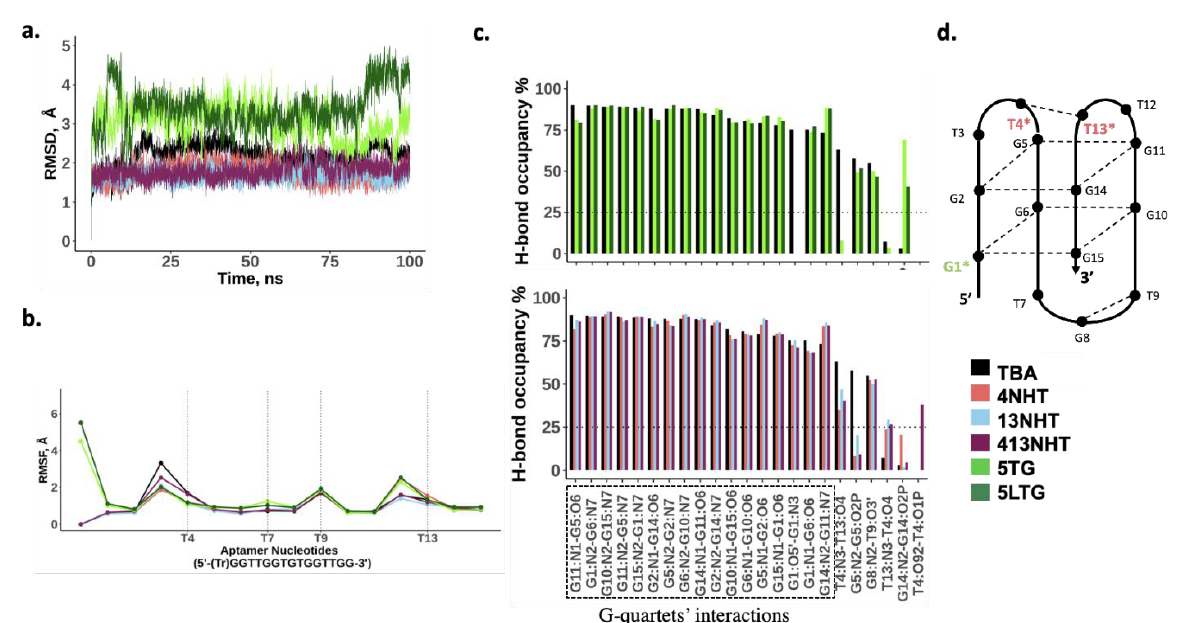
Figure 4. MD simulation results for the thrombin free aptamers. ( a ) Root mean square deviation from the initial structure; ( b ) Average root mean square fluctuations for each nucleotide in the native and modified aptamer. Trebler group is treated as a separate nucleotide; ( c ) Bond occupancies for intra-hydrogen bonds in the aptamer. Only H-bonds with at least 25% occupancies are shown ( d ) Schematic showing h-bond interactions within the aptamer.